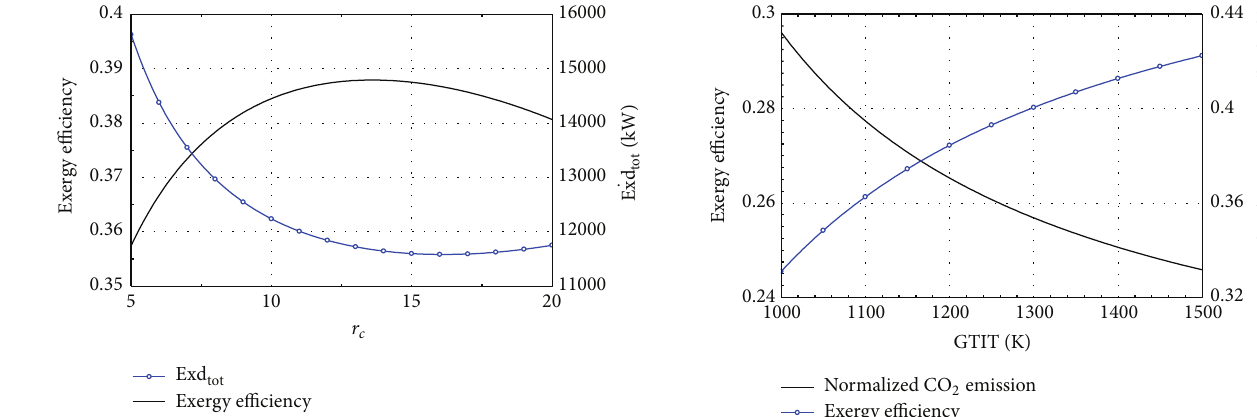
Figure 6: Variation with gas turbine inlet temperature of exergy ef- ficiency and normalized CO 2 emission.